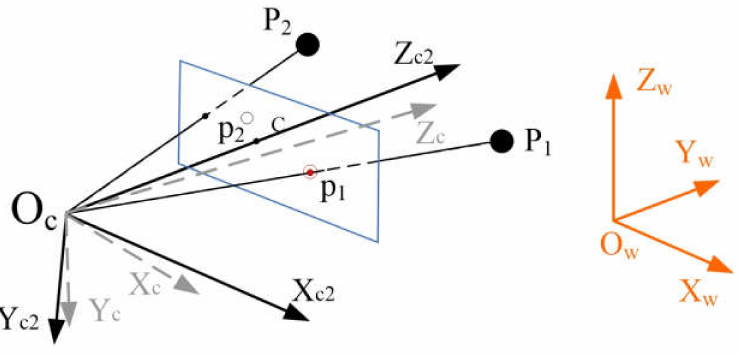
Figure 4. Camera frame O_ZYZ_c 2. Now the 2D–3D point correspondence between point p 1 and point P 1 is